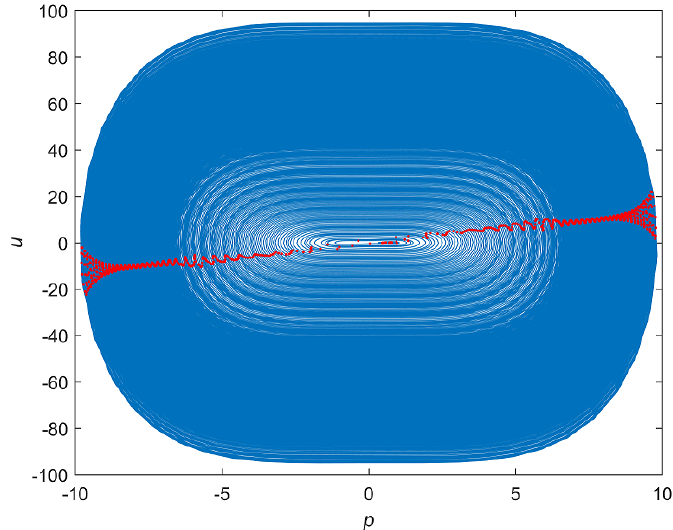
Figure 5. p - u phase portrait and the corresponding Poincaré map (red points) on the section q = 0.